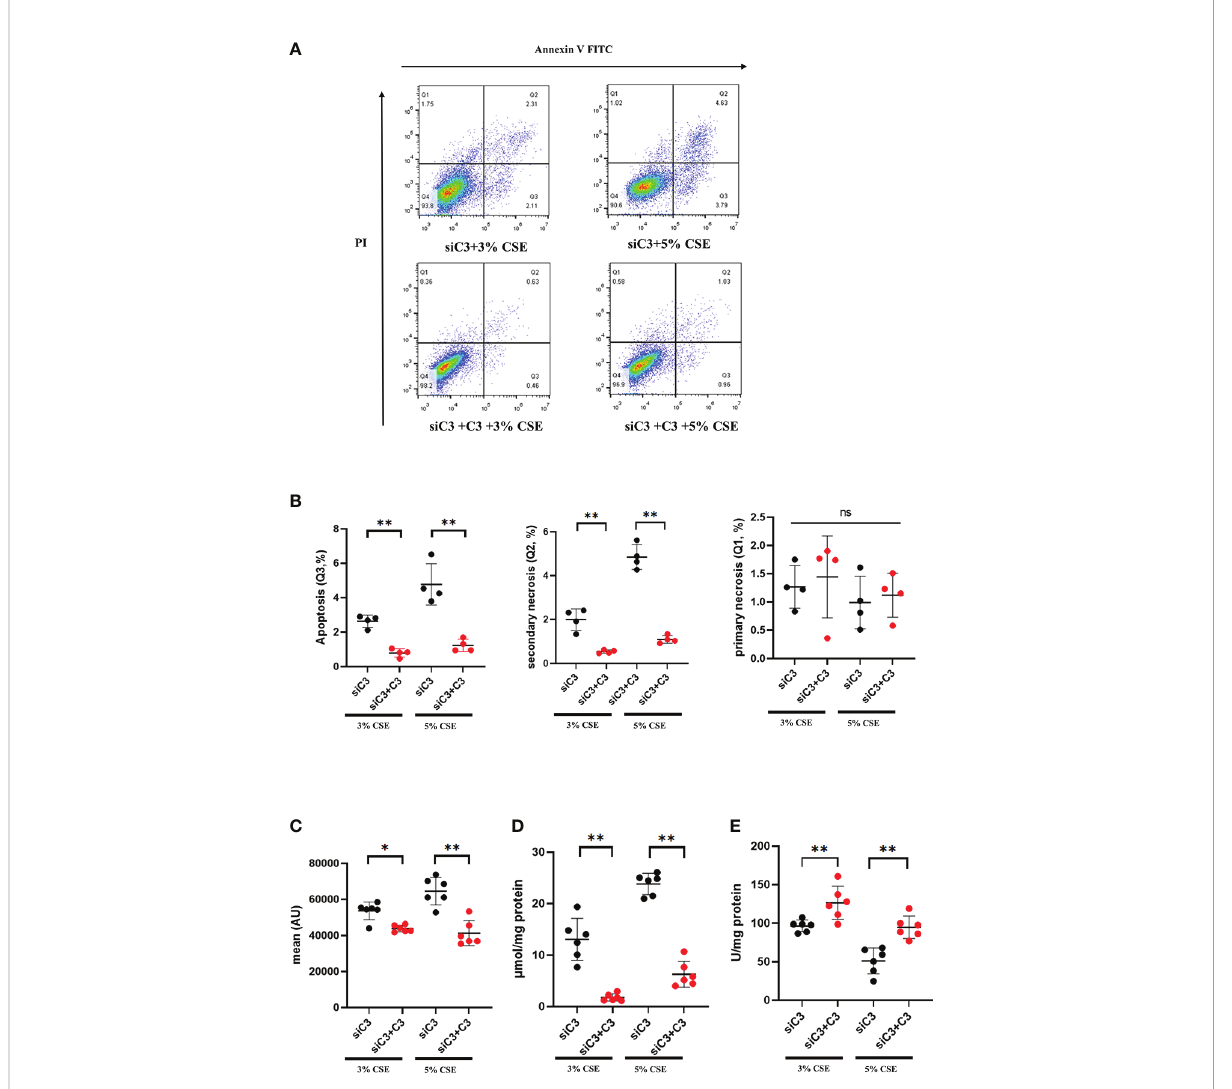
FIGURE 5 Exogenous C3 prevents CSE-induced oxidative stress and apoptosis in C3 knockdown human AECs. 16HBE cells were transfected with siControl or siRNA targeting human C3. Cells were then treated with CSE (3% and 5% concentration, respectively) in the absence or presence of exogenously added C3 (15 ug/ml) for 24 h. (A) The proportion of apoptosis cells(Q3), secondary necrotic cells (Q2) and primary necrotic cells (Q1) were determined using annexin (x-axis) and propidium iodide (PI, y-axis) staining by fl ow cytometry. (B) Representative analysis plot of cell apoptosis, secondary necrosis and primary necrosis. ** P < 0.01. (C-E) MDA assay kits were used to measure MDA content, SOD assay kits were used to measure SOD content, and the DCFH-DA method was used to measure ROS production. Data were expressed as mean ± S.D. N = 6 independent experiments. * P values < 0.05, ** P < 0.01, ns, no signi fi